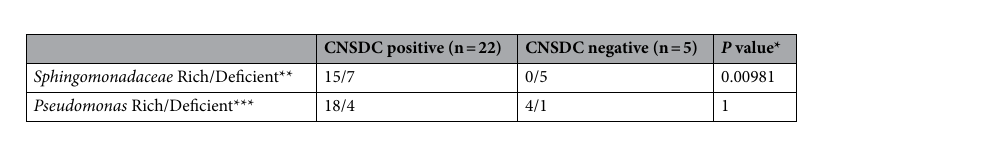
Table 3. Relationship between the mucosa-associated microbiota and CNSDC. CNSDC, chronic non- suppurative destructive cholangitis. *Comparisons using Fisher’s exact test. **The cutoff values were 0.0000179. ***The cutoff values were